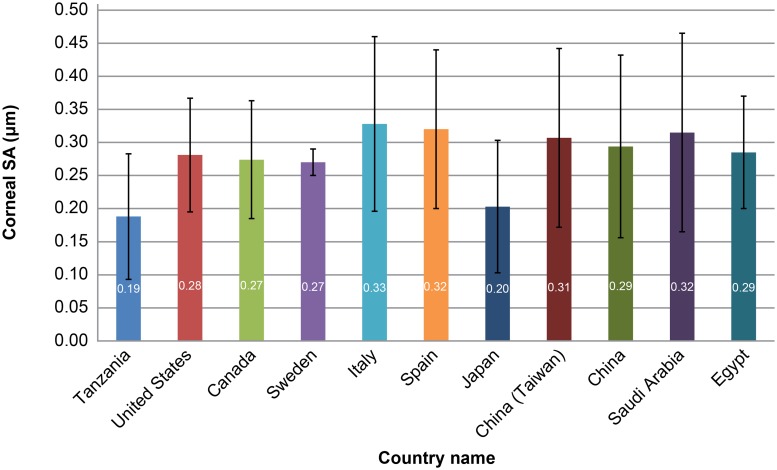
Comparison of corneal spherical aberrations (SA) at the 6-mm optical zone between this study and previous reports in individuals over the mean age of 40 years [2–5,10–15].The mean value of corneal SA in Tanzanian individuals was 0.19 μm, which tended to be small among the previously reported values.